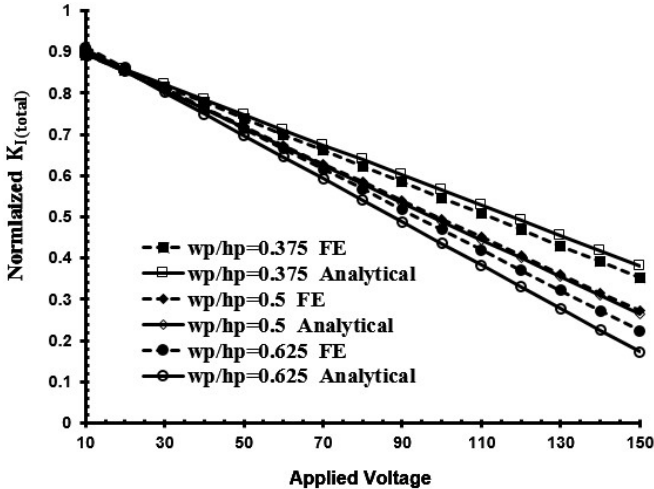
Figure 8. Variation of SIF with piezoelectric actuator size.